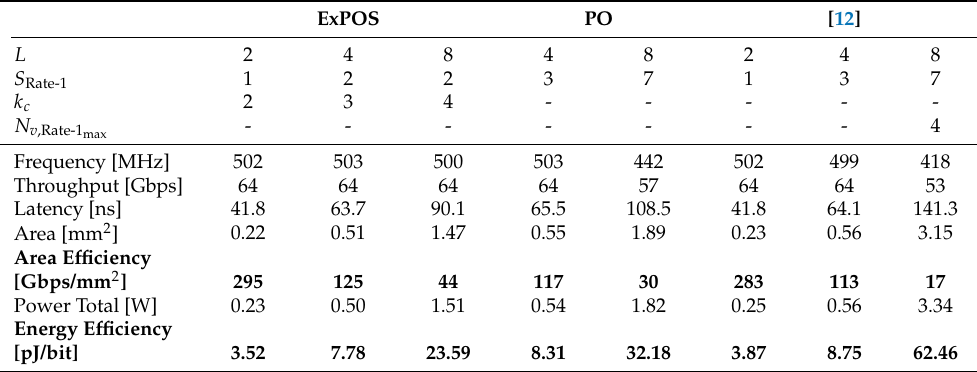
Table 2. Results of Fast-SSCL decoders for Polar codes with N = 128, K = 64 + 6, and C = 6. ExPOS PO [12] L 2 4